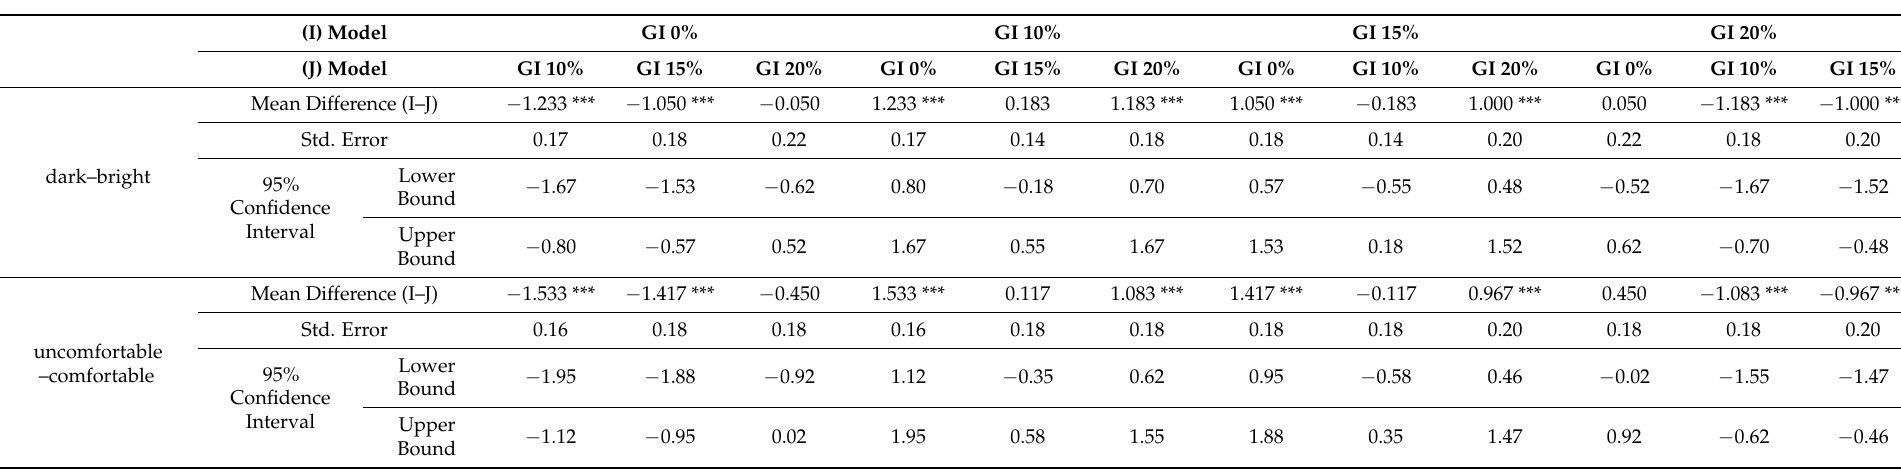
Table 13. Post-hoc Test Analysis for Interior Landscape Model Space Image in Ground